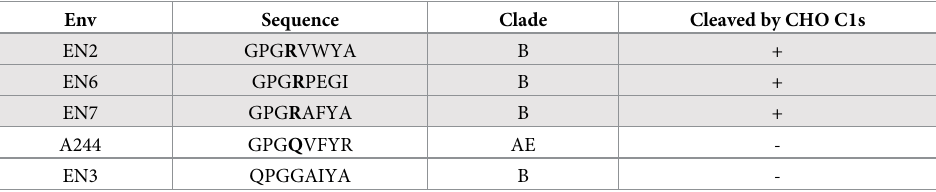
Table 2. V3 domain crown sequences for EN rgp120s.